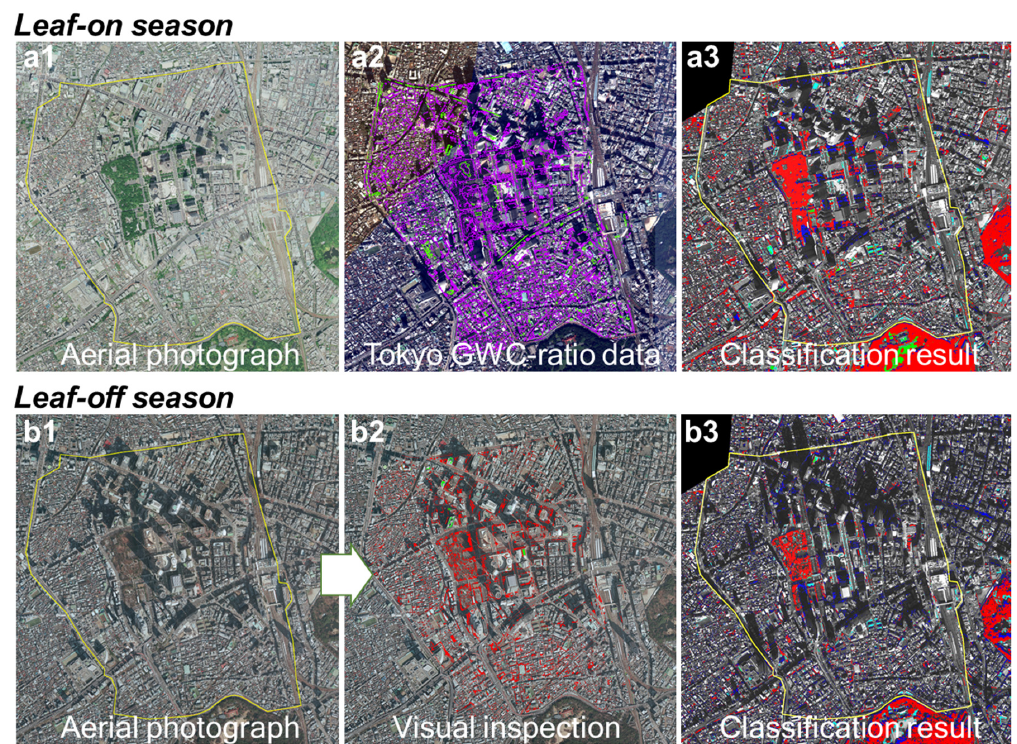
Figure 4. Mapping results of vegetation in the test area shown in Figure 2 ( A2 and B2 ) for leaf-on season (upper panels: a1–a3 ) and leaf-off season (lower panels: b1–b3 ). The areas enclosed by yellow lines are places where the comparisons were performed. ( a1 ) Aerial photograph taken in May 2012 (leaf-on season). ( a2 ) Tree canopy cover (purple) and grass (green) based on the Tokyo Green and Water Coverage ratios data (Tokyo GWC-ratio data) derived from aerial photograph interpretation. ( b1 ) Aerial photograph taken in March 2013 (leaf-off season). ( b2 ) Manually delineated tree canopy cover (red) and grass (green). ( a3 and b3 ) Tree canopy cover (red), grass (dense = green; sparse = light blue), and vegetation in shadow (blue) from the WorldView-2/3 imagery. Satellite imagery from DigitalGlobe Products. ( a2 and a3 ) WorldView3 © 2020 DigitalGlobe, Inc., a Maxar company. ( b3 ) WorldView2 © 2020 DigitalGlobe, Inc., a Maxar company. ( a1 , b1 , and b2 ) Aerial photograph © NTT GEOSPACE CORPORATION.